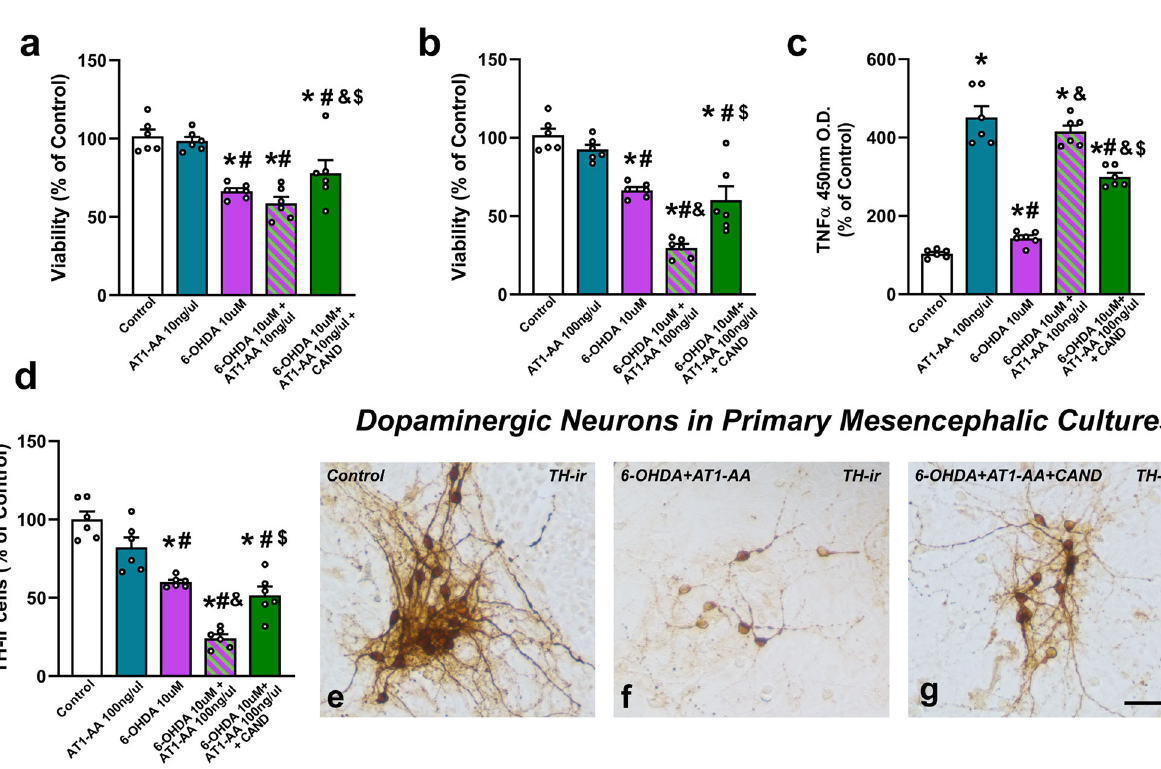
Fig. 3 Primary mesencephalic cultures showing that AT1-AA enhance the deleterious effects of 6-OHDA (10 µM). In 6-OHDA-treated cultures, deleterious effects on cell viability are not signi fi cant with a dose of 10 ng/µl AT1-AA (i.e. 10 µM 6-OHDA + 10 ng/µl AT1-AA) ( a ) but are signi fi cant at 100 ng/µl (i.e. 10 µM 6-OHDA + 100 ng/µl AT1-AA), as revealed by the MTT assay ( b) and TH-positive neuron counting (d ), which was inhibited by the AT1 receptor blocker candesartan. AT1-AA alone did not induce signi fi cant decrease in cell viability ( a, b, d